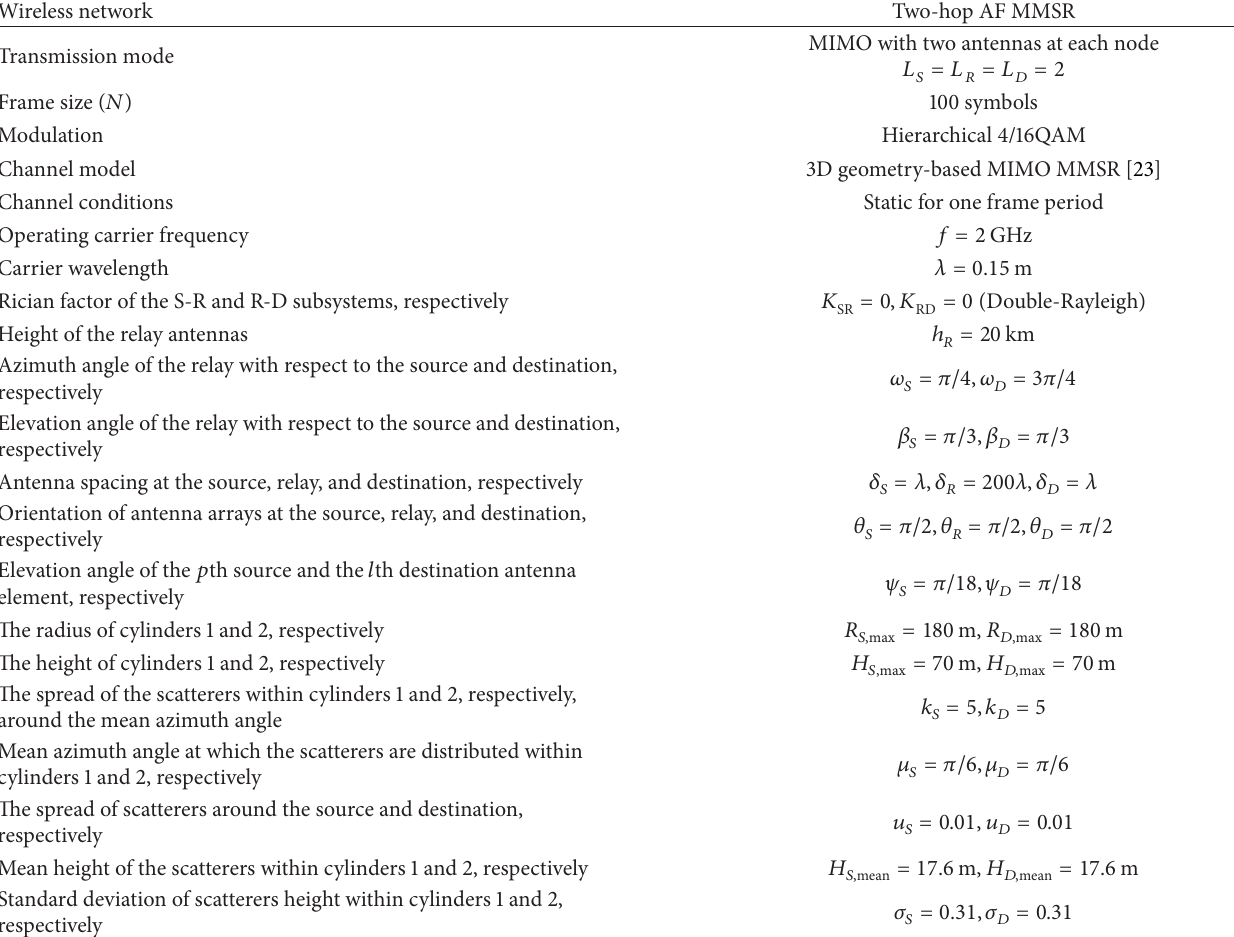
Table 1: System parameters used in the performance